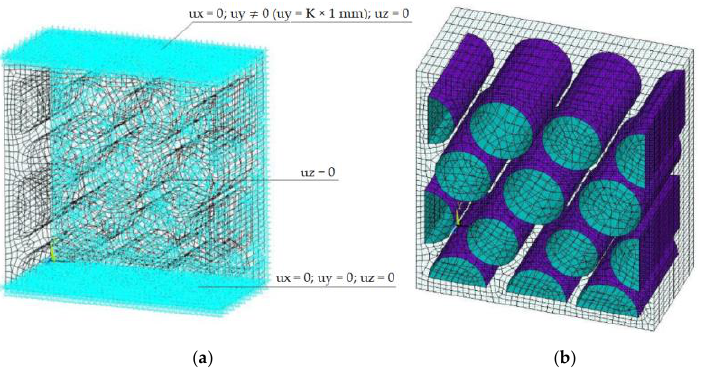
Figure 7. Applied boundary conditions ( a ) and development of contact surfaces between the wood and mortar ( b ).